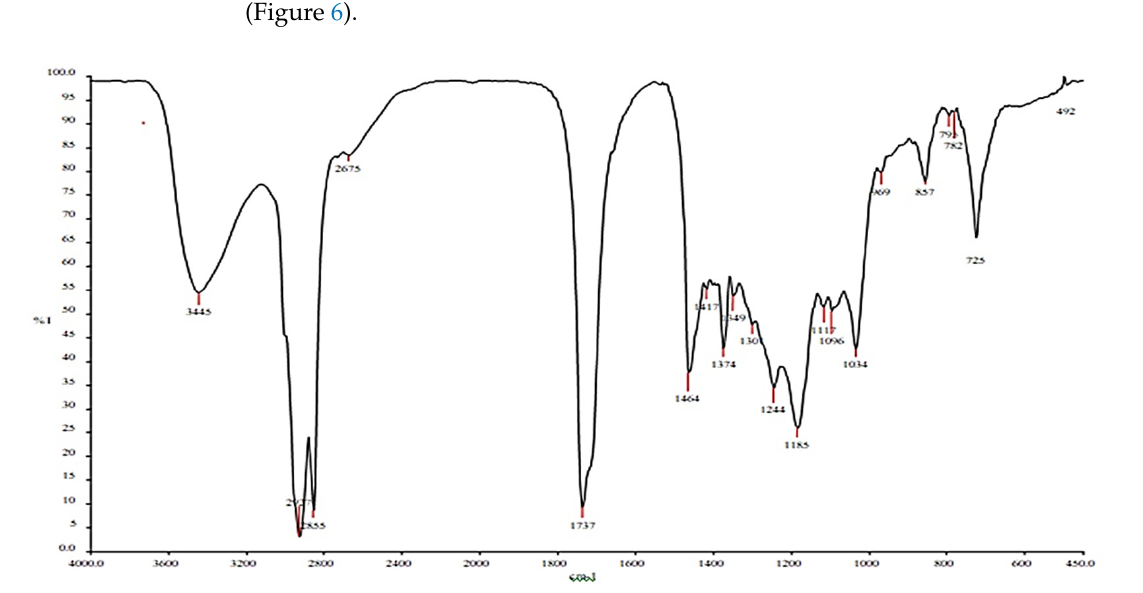
Figure 6. Fourier transform infrared (FTIR) spectrum of the purified compound from the extracts of Leucas indica flowers.